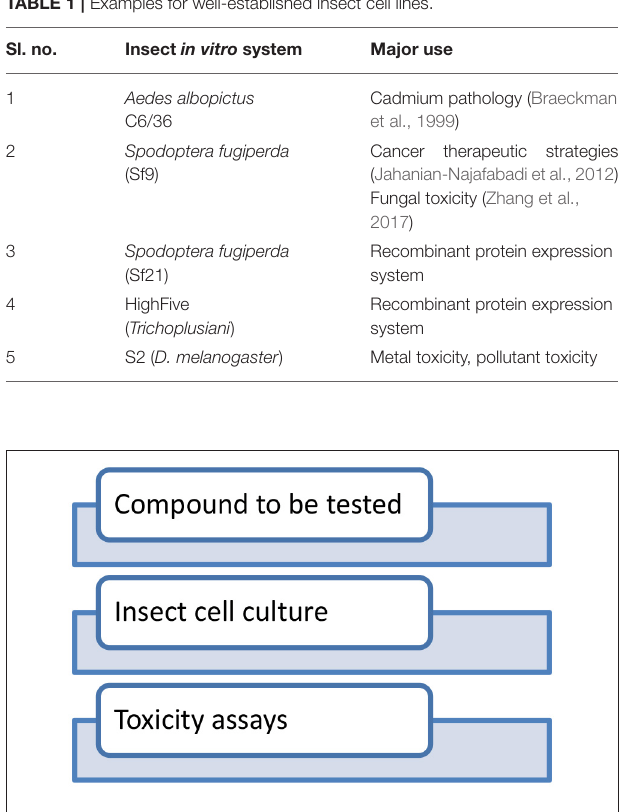
FIGURE 1 | Schematic workflow of the toxicity testing using insect cell lines.